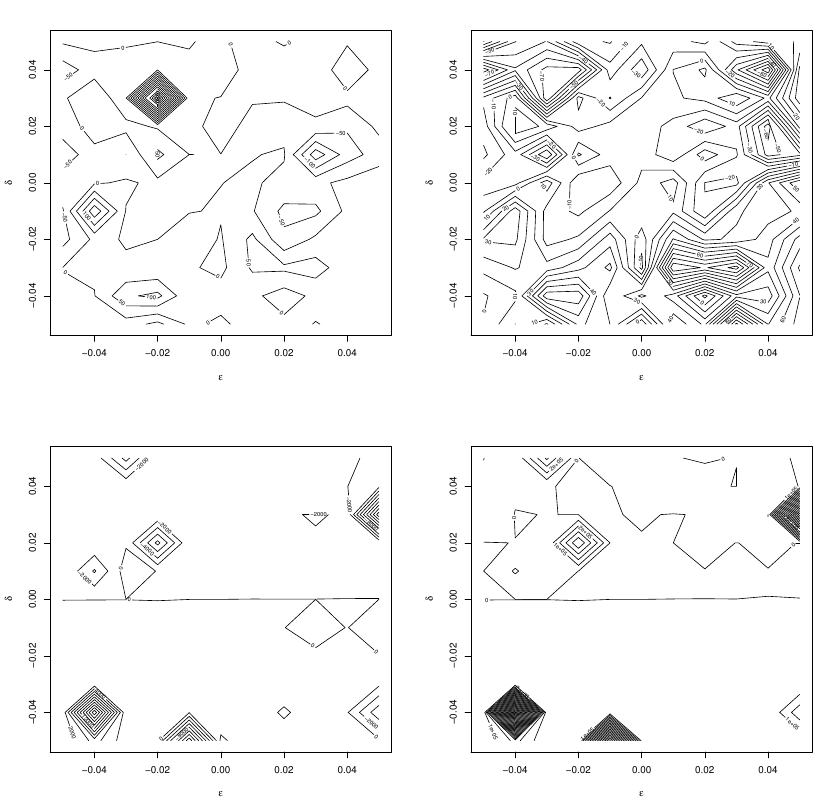
Figure 3 – Contours of the relative percentage changes in the bias of the estimator of α (top left), the MSE of the estimator of α (top right), the bias of the estimator of β (bottom left) and the MSE of the estimator of β (bottom right) when n =